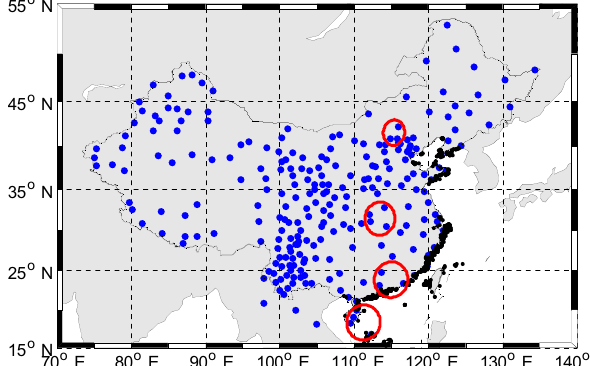
Figure 1. Location of GPS receiver stations. The four red circles denote the given stations of four arrays which are Array 1 (HECC- HEZJ-NMZL), Array 2 (HAQS-HBJM-WUHN), Array 3 (GDSG- GDST-GUAN), and Array 4 (HISY-QION-YONG).